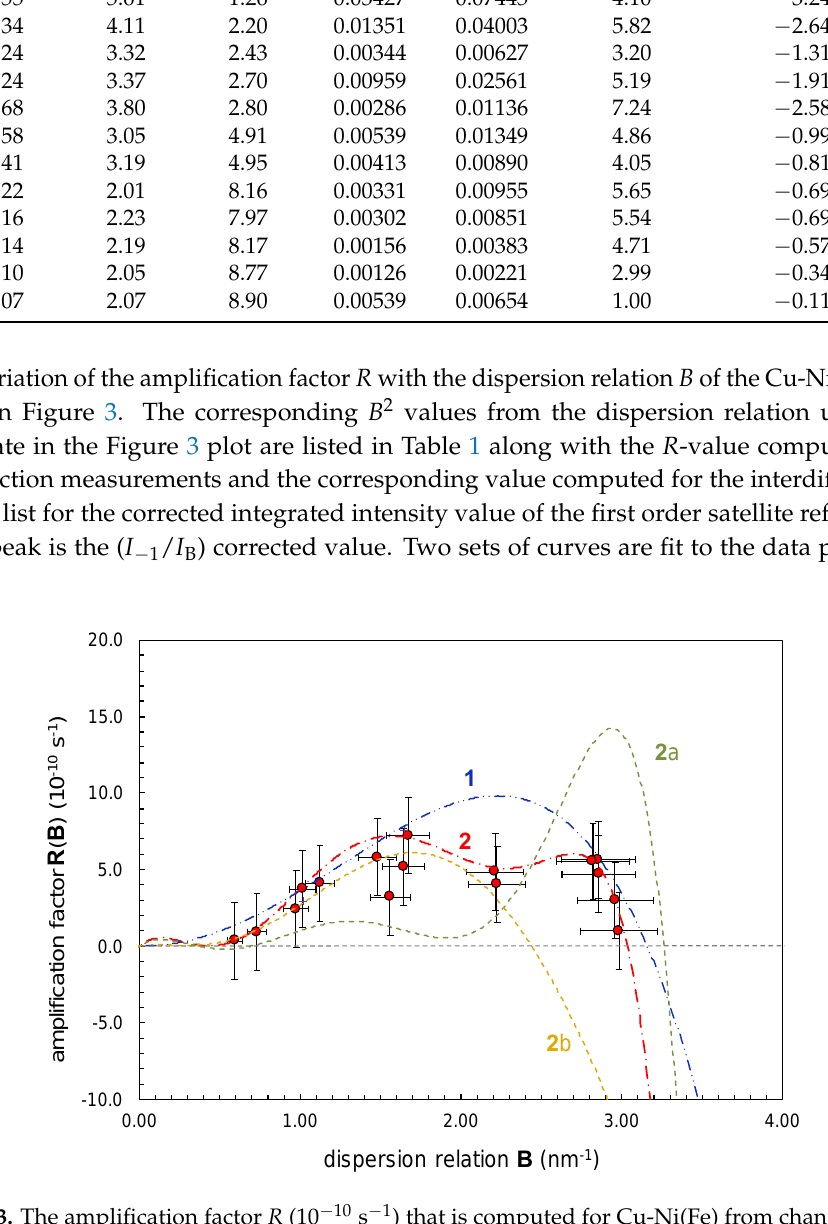
Figure 3. The amplification factor R (10 −10 s −1 ) that is computed for Cu-Ni(Fe) from changes in the X-ray diffraction profile is plotted as a function of the dispersion relation B (nm −1 ) wavenumber.